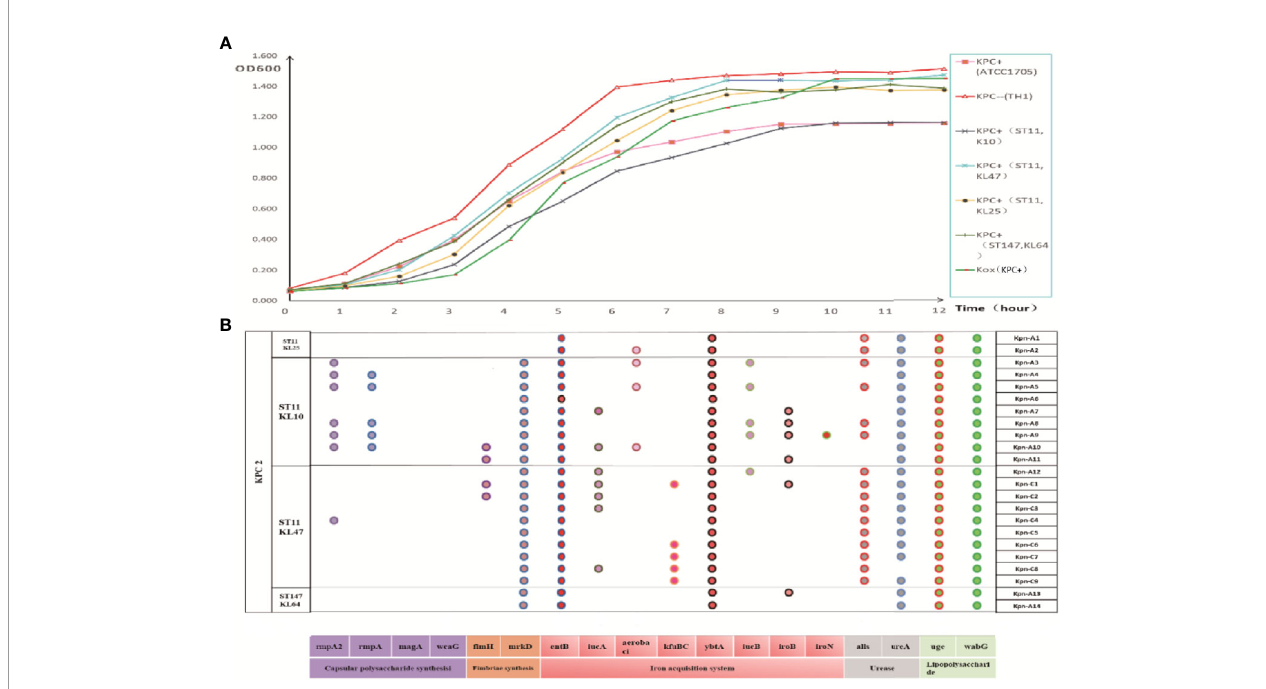
FIGURE 3 | (A) Growth curve of each group of strains. The data exhibited are the average absorbance values of three independent experiments. (B) Distribution of virulence gene in strains. The presence of virulence genes in a speci fi c genome is indicated by different colored circles. Virulence genes and their roles are shown at the